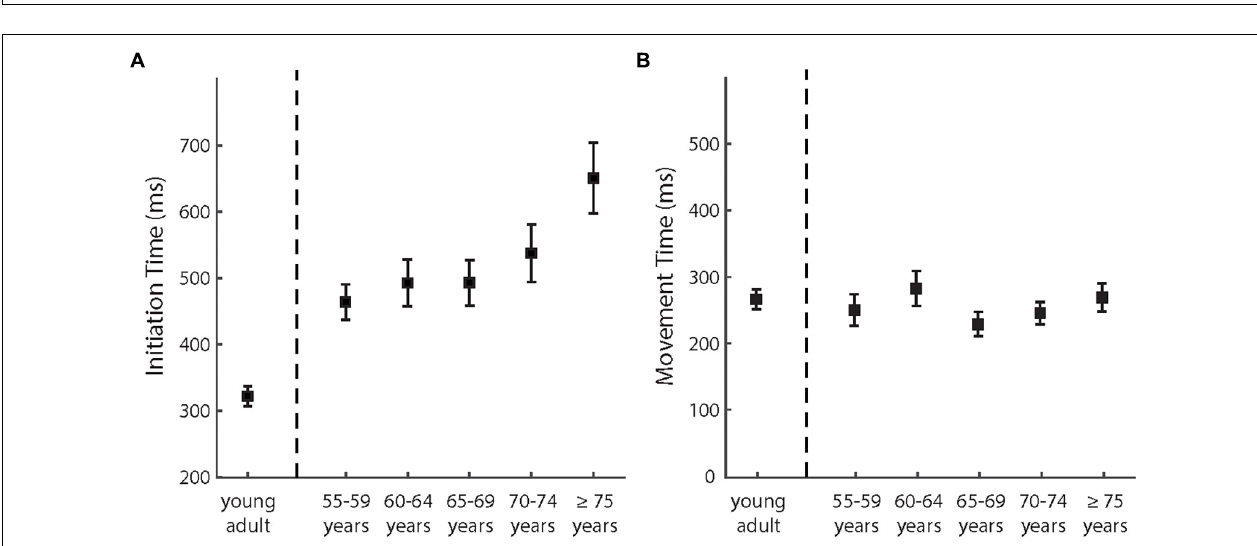
FIGURE 5 | (A) The mean initiation times and (B) the mean movement times of different age groups in the adaptation phase. The error bars depict ± 1 standard errors.